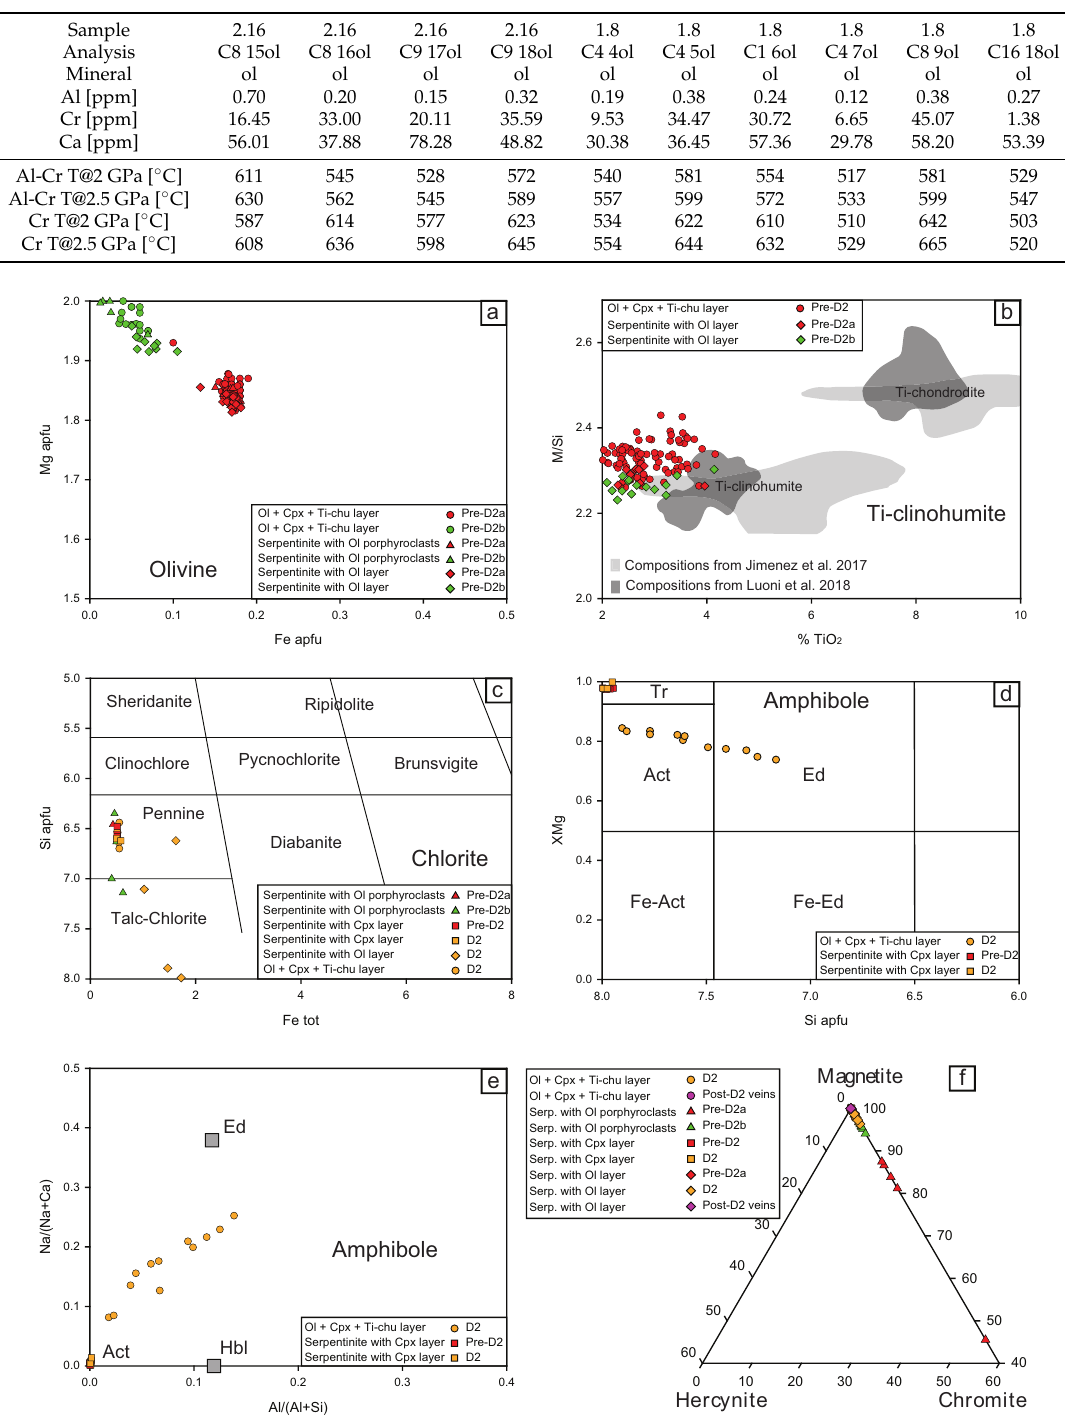
Figure 8. Mineral chemistry diagrams of the most representative minerals. ( a ) Fe vs. Mg in olivine with two clusters of data representing the first and the second generation of Ol minerals, the first one is richest in Fe; ( b ) TiO 2 wt% vs. M/Si in Ti-Clinohumite. Compositions from González-Jiménez et al. [132] - light grey - and Luoni et al. [21] - dark grey - are shown for comparison; ( c ) Chlorite classification diagram Fe tot vs. Si; ( d , e ) Amphibole classification diagrams Si vs. X Mg and Al/(Al + Si) vs. Na/(Na + Ca); ( f ) Hercynite-Chromite-Magnetite ternary diagram with spinels from different